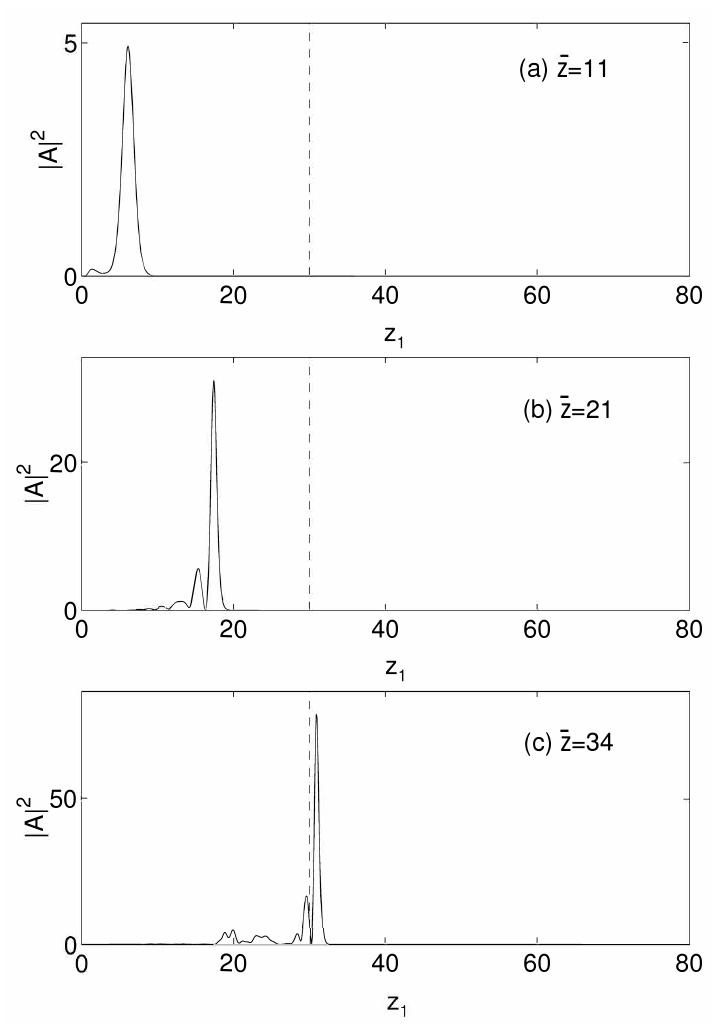
Figure 7. Strong pure superradiance, with l b = 30 l c , δ = 2 and different values of ¯ z : ( a ) ¯ z = 11; ( b ) ¯ z = 21; ( c ) ¯ z =